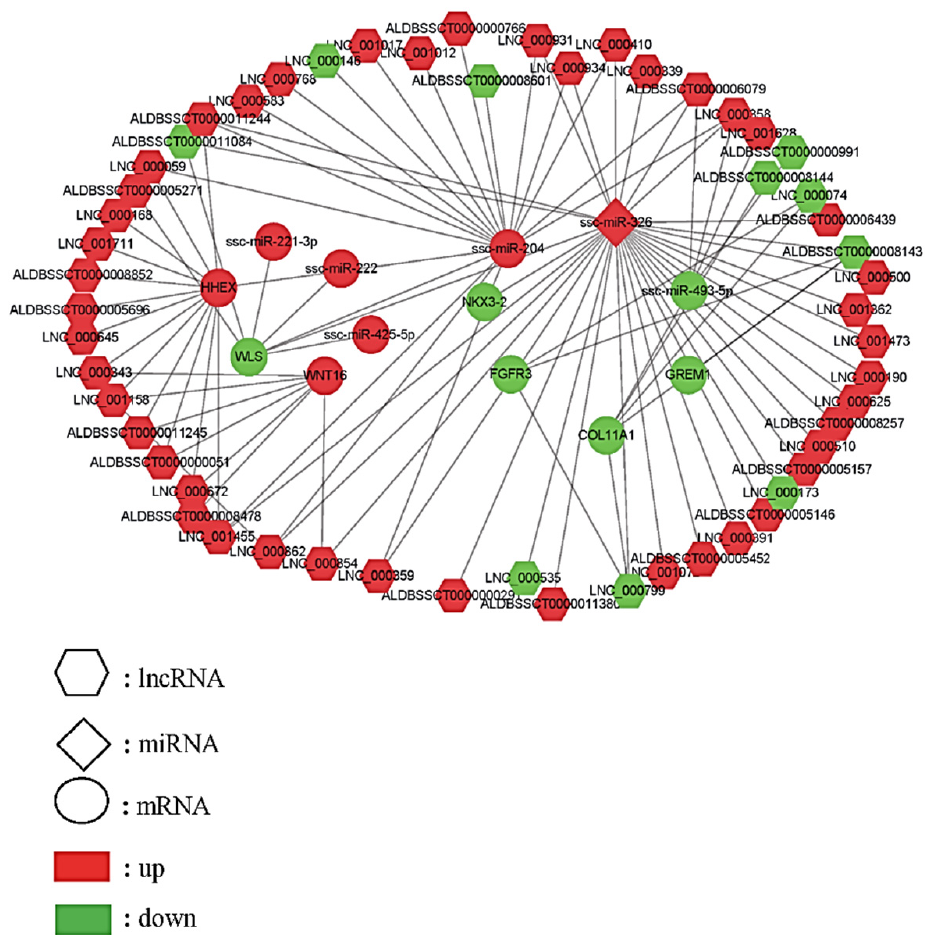
Figure 3. LncRNA, microRNA, and key candidate gene interaction network construction. Hexagonal, prismatic, and circular symbols represent the lncRNA, miRNA, and mRNA, respectively; red represents an up-regulation, and green represents a relative down-regulation compared to the 1-month-old pigs.